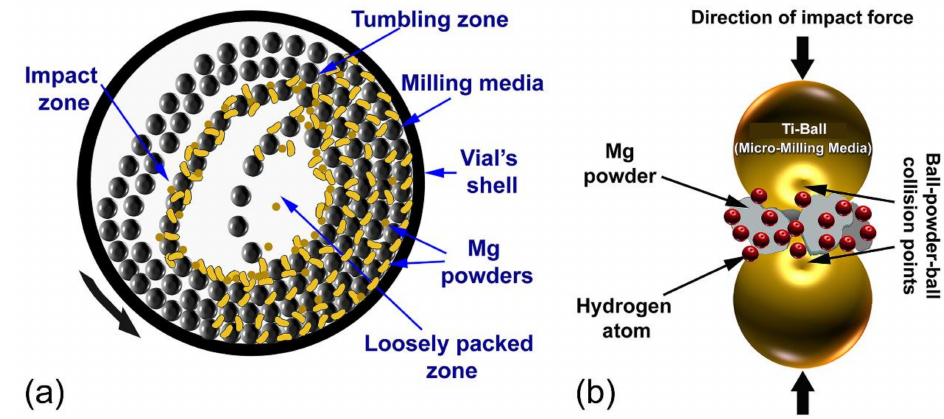
Figure 6. Schematic presents the ( a ) movement of the balls and materials (Mg shots and powders) inside a sealed cylindrical vial, which is pressurized with 15 bar of H 2 gas, and ( b ) ball-powder-ball collision during RBM process, using a tumbler ball mill.